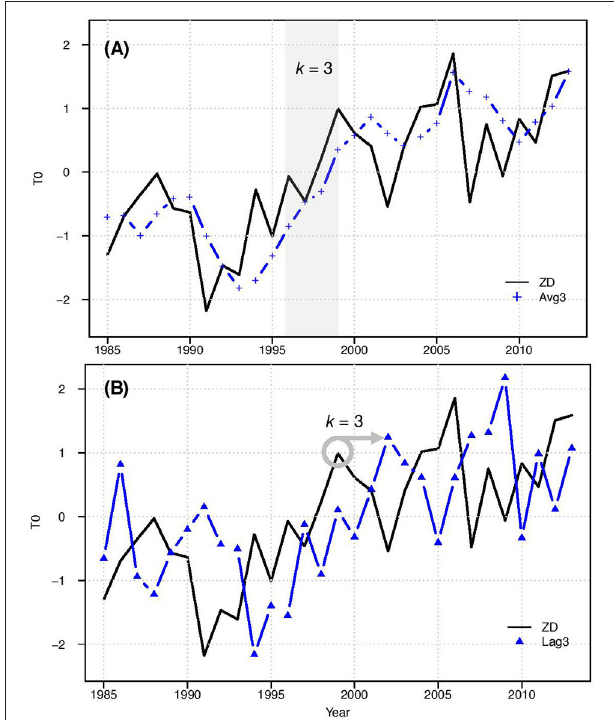
FIGURE 4 | Illustration of the different types of time delays for surface temperature (SST) at k = 3: (A) moving average; (B) forward lag shift.